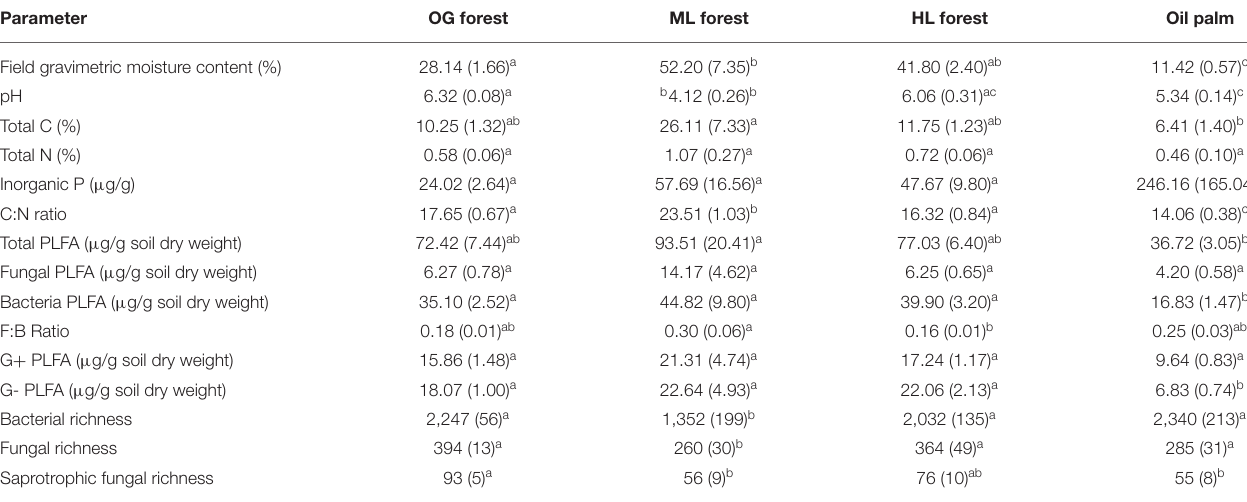
TABLE 2 | Soil properties, PLFA concentrations, and microbial richness (number of observed ASV’s) measured across old growth (OG) forest, moderate logged (ML) forest, heavily logged (HL) forest, and oil palm plantation. Parameter OG forest ML forest